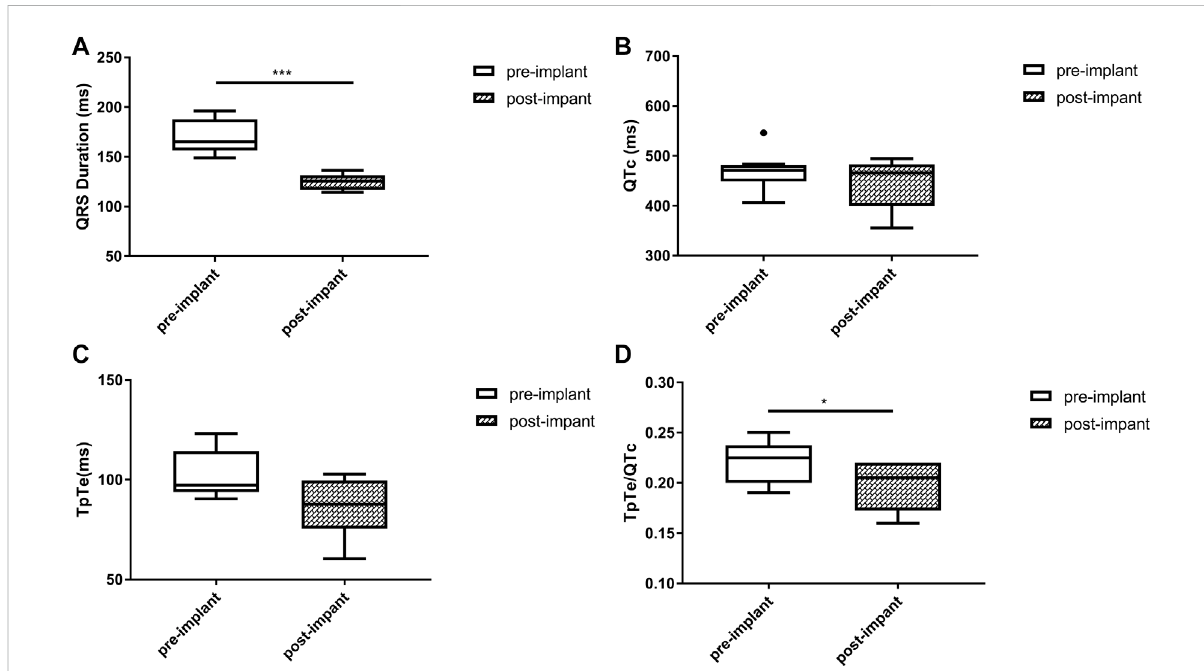
FIGURE 4 Changes in QRS duration (A) , QTc (B) , TpTe (C) , TpTe/QTc (D) before and after LBBAP in patients with prior right ventricular paced rhythm ( n = 8). (Box plots exhibited the smallest nonoutlier, fi rst quartile, median, third quartile, and largest non-outlier of each variable from bottom to top. LBBAP left bundle branch area pacing; QTc, QT corrected measurement; TpTe, Tpeak-Tend interval. * p < 0.05, ** p < 0.01, *** p < 0.001).